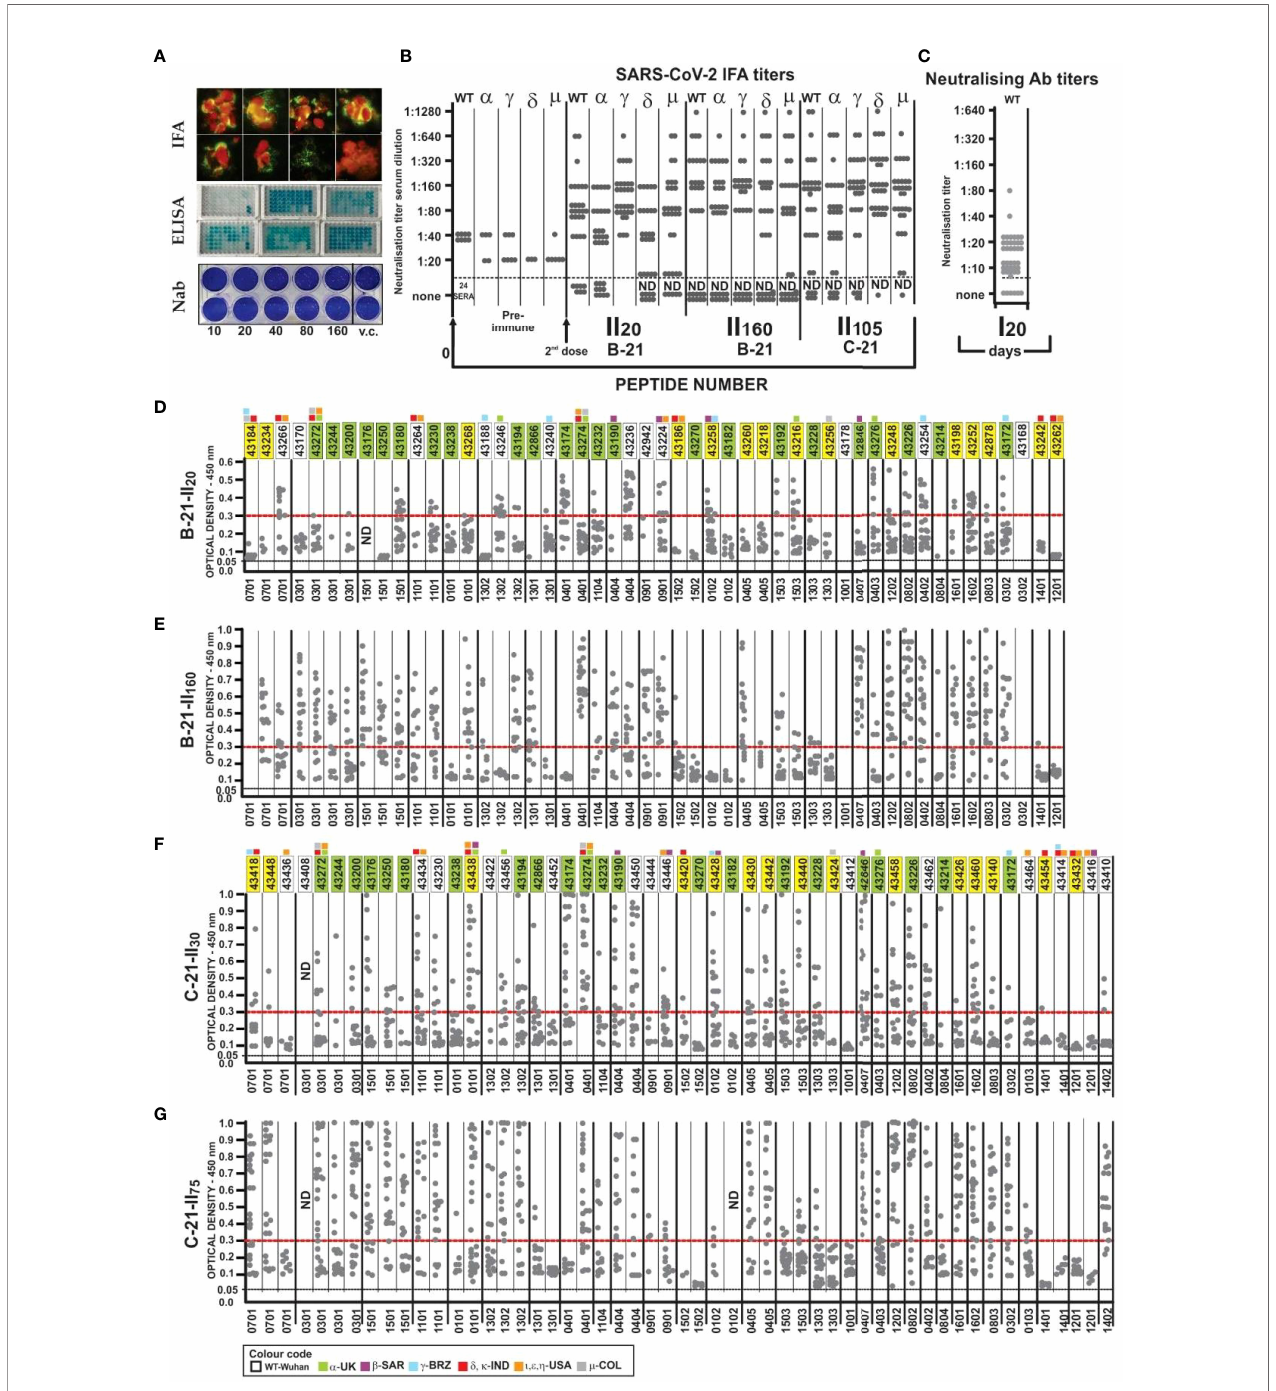
FIGURE 8 | Immunological results. (A) IFA reactivity, Aotus sera ( fl uorescent green) with SARS-CoV-2 human/Medellin/V A1/2020 strain. ELISA assay, Aotus sera recognition of native peptides; NAb titres (sera dilution), viral control (vc). (B) Aotus pre-immune sera IFA titres 20 (II 20 ), 105 (I1 105 ), and 160 days (I1 160 ) after the second dose in B-21 and C-21 in two-fold dilution with VERO cells infected with wild-type (B.1/D614G), Alpha, Beta, Gamma, Delta, and Mu variants. (C) NAb titres with wild-type B.1/D614G (WT) with Aotus sera. (D – G) Aotus sera reactivity (ELISA: 1:100 dilution) against unmodi fi ed parental peptides at 450-nm OD with B-21 (II 20 and II 160 ) and C21 (II 30 and II 75 ) serum samples grouped according to the HLA-DR b 1* to which they bound (the HLA-DR b 1* associated with each peptide is shown below D, E, F, and G). The fi rst region containing 22 peptides common to B-21 and C-21 , 15 having aa sequence variations (1-3 aa) and 13/50 new ones in B21 and 16/53 in C21 (colourless), to include new VOC variations, OD 0.05 baseline and above 0.30 strong